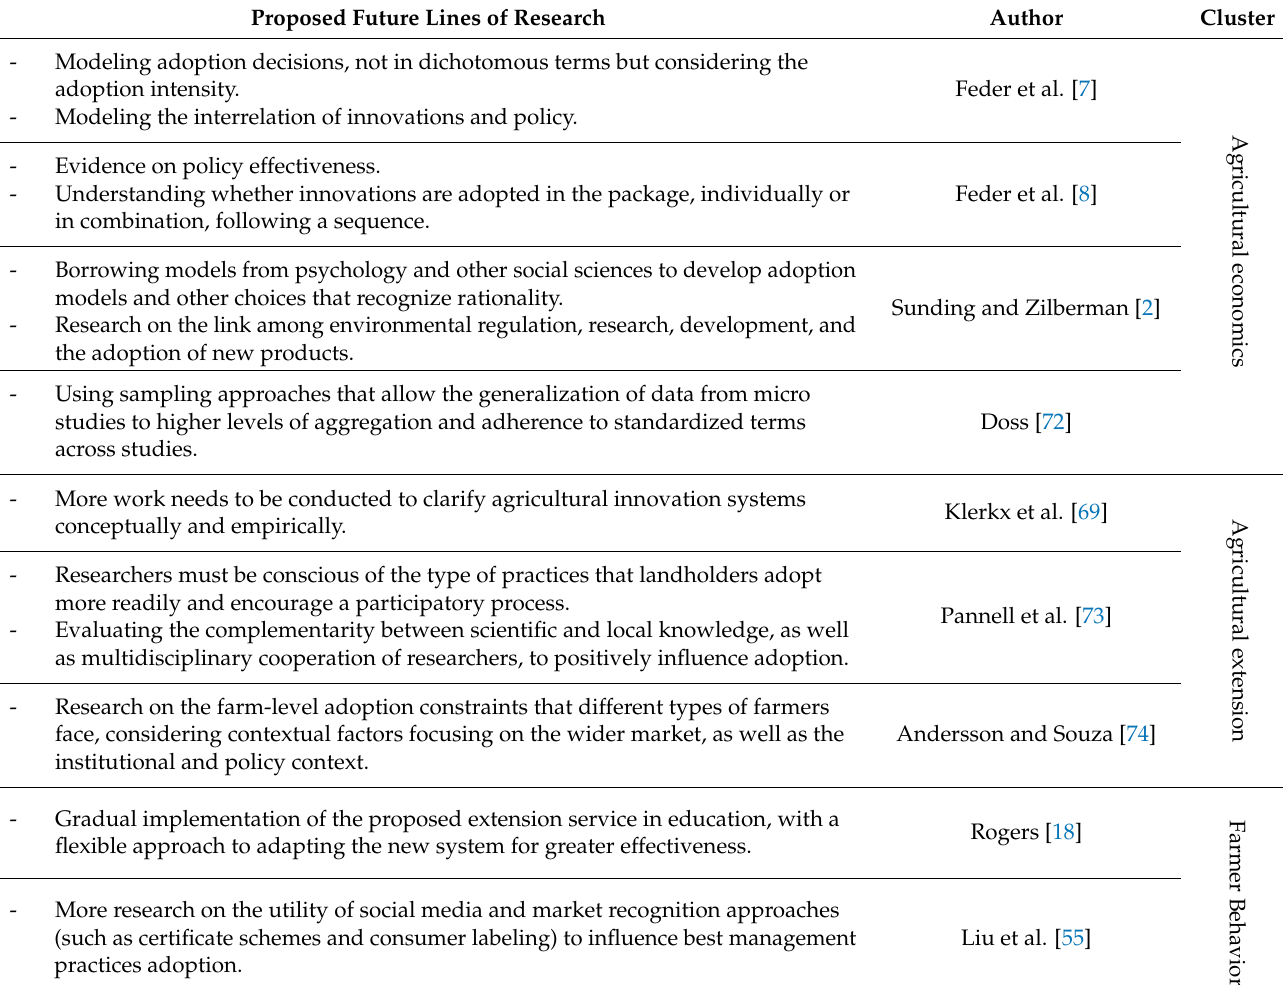
Table 3. Future lines of investigation as suggested by the research